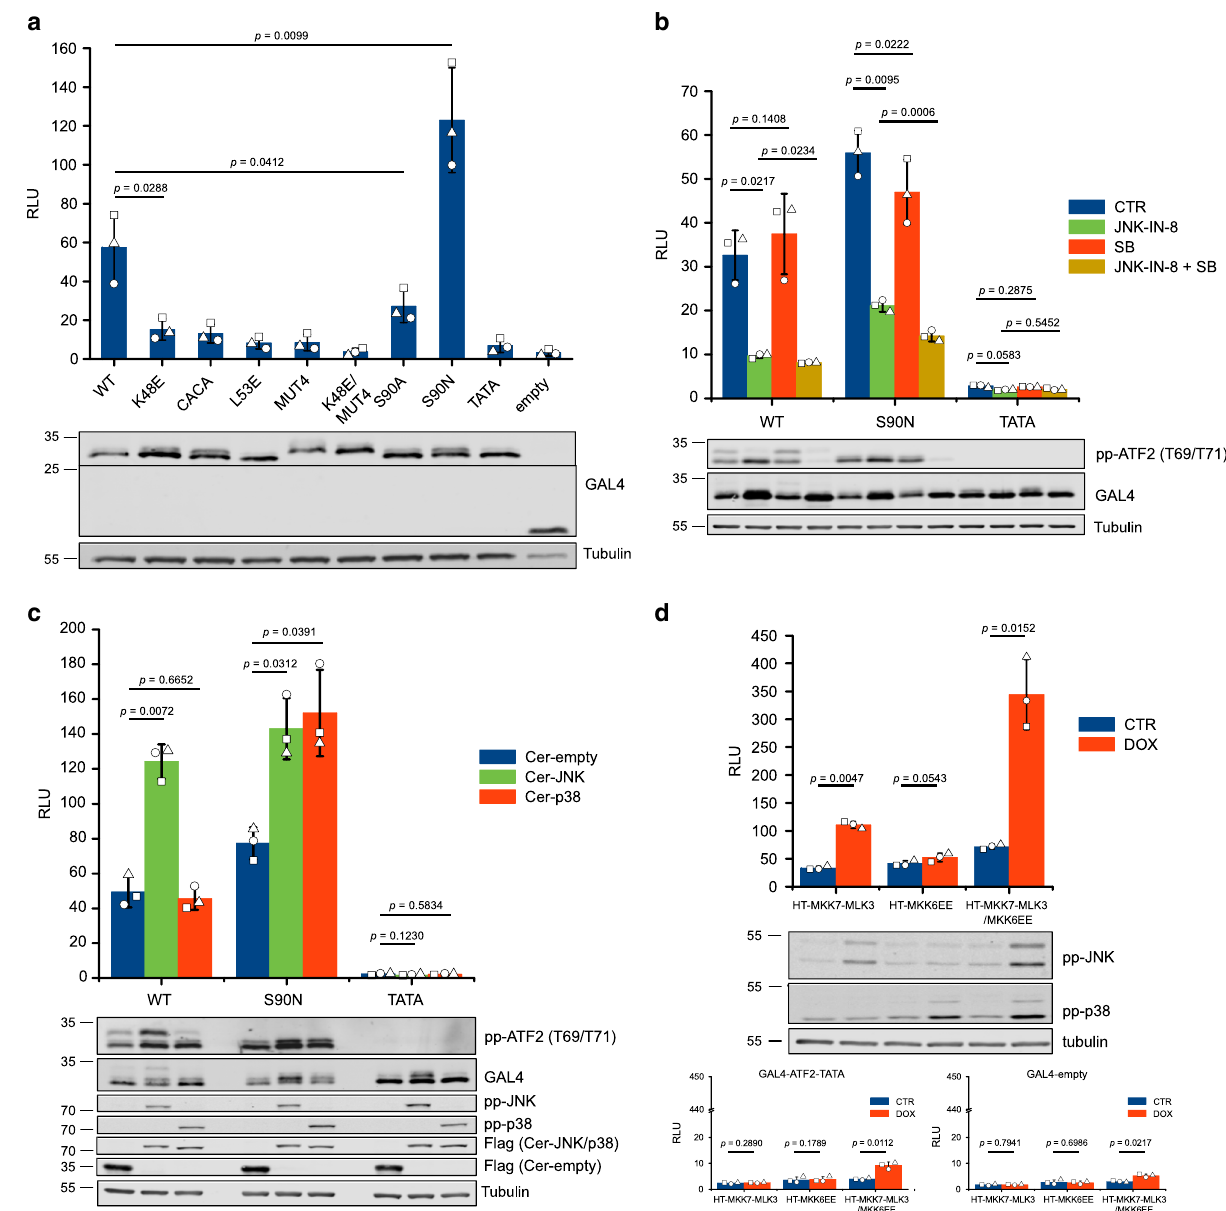
Fig. 6 Co-regulation of ATF2 TAD mediated transcription by JNK and p38. a The effect of different TAD residues on basal transcription. HEK293T cells were transfected with a GAL4-luciferase reporter plasmid and GAL4-TAD fusion expression constructs. Non-phosphorylatable GAL4-ATF2-TATA(T69A/ T71A) and empty GAL4 constructs were also included as negative controls. RLU: relative luminescence unit (RLU). Panels below show results of western- blots: similar expression of different GAL4-TAD fusions were con fi rmed by using anti-GAL4 antibody and anti-tubulin antibody was used as load control. b The effect of JNK- or p38-speci fi c inhibitors on TAD mediated basal transcription. Relative luminescence (RLU) was measured after treating cells with 1 µ M JNK inhibitor (JNK-IN-8), 1 µ M p38 inhibitor (SB, SB202190) or both inhibitors (JNK-IN-8 + SB), while 0.1% DMSO solvent was used as control (CTR). Panels below show western-blot results using anti-pp-ATF2(T69/T71), anti-GAL4 or anti-tubulin antibody. Note that the upper band on the pp-ATF2(T69/ 71) blot corresponds to GAL4-TAD fusions phosphorylated on S90. c Ser90 phosphorylation by JNK limits p38-mediated transcriptional activation. GAL4- ATF2-(19 – 100)-WT, -S90N, and -TATA constructs were co-transfected with Cerulean-empty-FLAG (Cer-empty), Cerulean-JNK1-FLAG (Cer-JNK) or Cerulean-p38 α -FLAG (Cer-p38) expression plasmids. Phosphorylation of ATF2-TADs were detected by western-blot using anti-pp-ATF2(T69/T71) antibody. Expression of Cerulean constructs was detected using anti-FLAG antibody and increased levels of MAP kinase activation were con fi rmed by using anti-pp-JNK (T183/Y185) and anti-pp-p38 (T180/Y182) antibodies. d JNK and p38 synergistically increase TAD mediated activation. HEK293T Tet- on (HT) cell lines for inducible expression of MKK7-MLK3, MKK6-EE or both (MKK7-MLK3/MKK6-EE) were transfected with GAL4-ATF2-TAD(19 – 100)- WT (upper panel) or -TATA and empty constructs (lower panels). Endogenous MAPKs (JNK, p38 or both) were switched on by adding doxycycline (DOX). CTR — control, no DOX treatment. Error bars on all bar charts show SD calculated based on three independent experiments ( n = 3). Bar charts show all data points and p -values calculated using a two-sided paired t -test. Source data are provided as a Source data fi